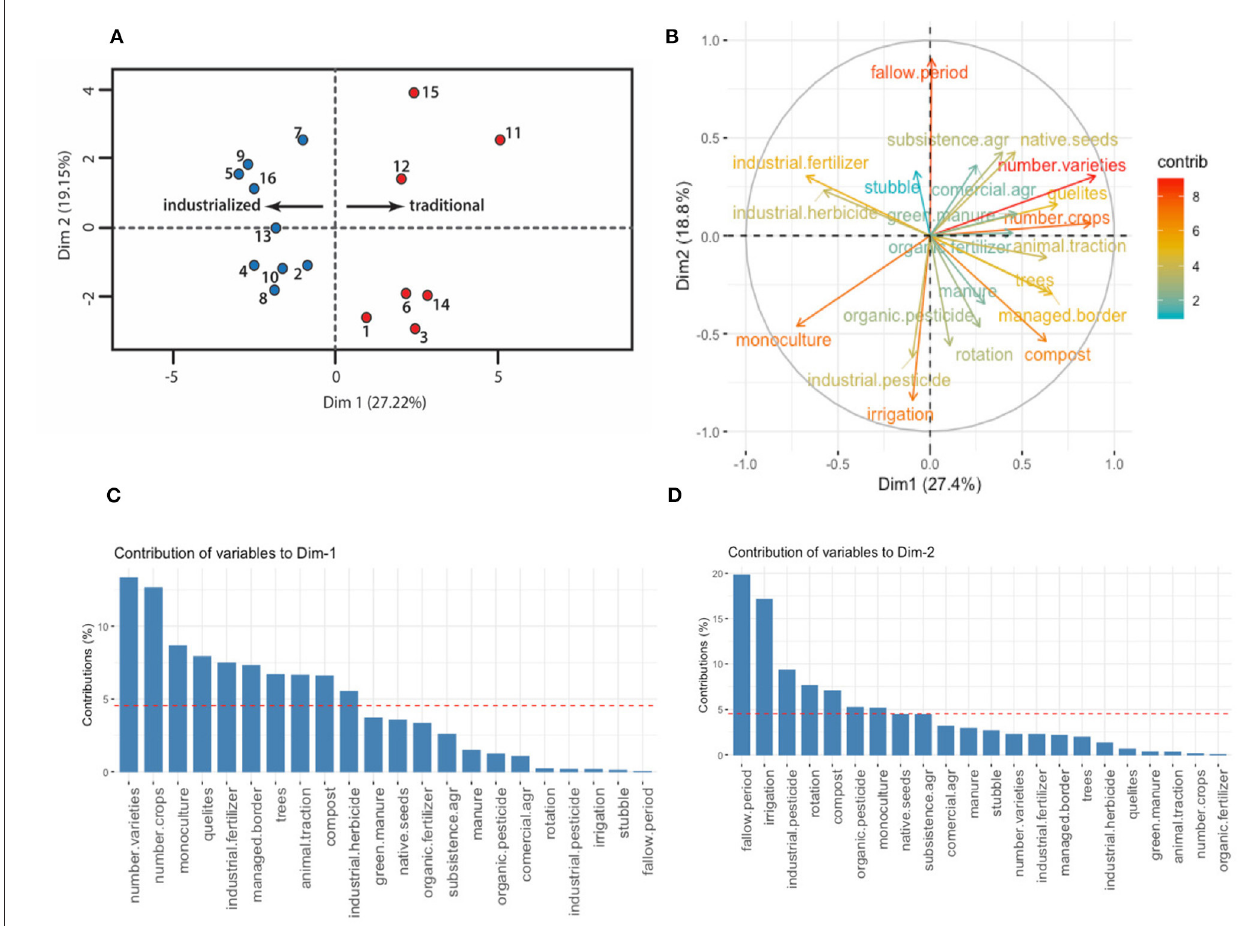
FIGURE 3 | FAMD analysis. (A) FAMD output for the 16 plots under study, plots on the left side correspond to the industrial management type and plots to the right correspond to the traditional management; (B) variables factor map, colors are given by each variable’s contribution to the first and second dimensions; (C) contribution of variables to the first dimension; (D) contribution of variables to the second dimension. The reference line in (C) and (D) corresponds to the expected value if the contributions were